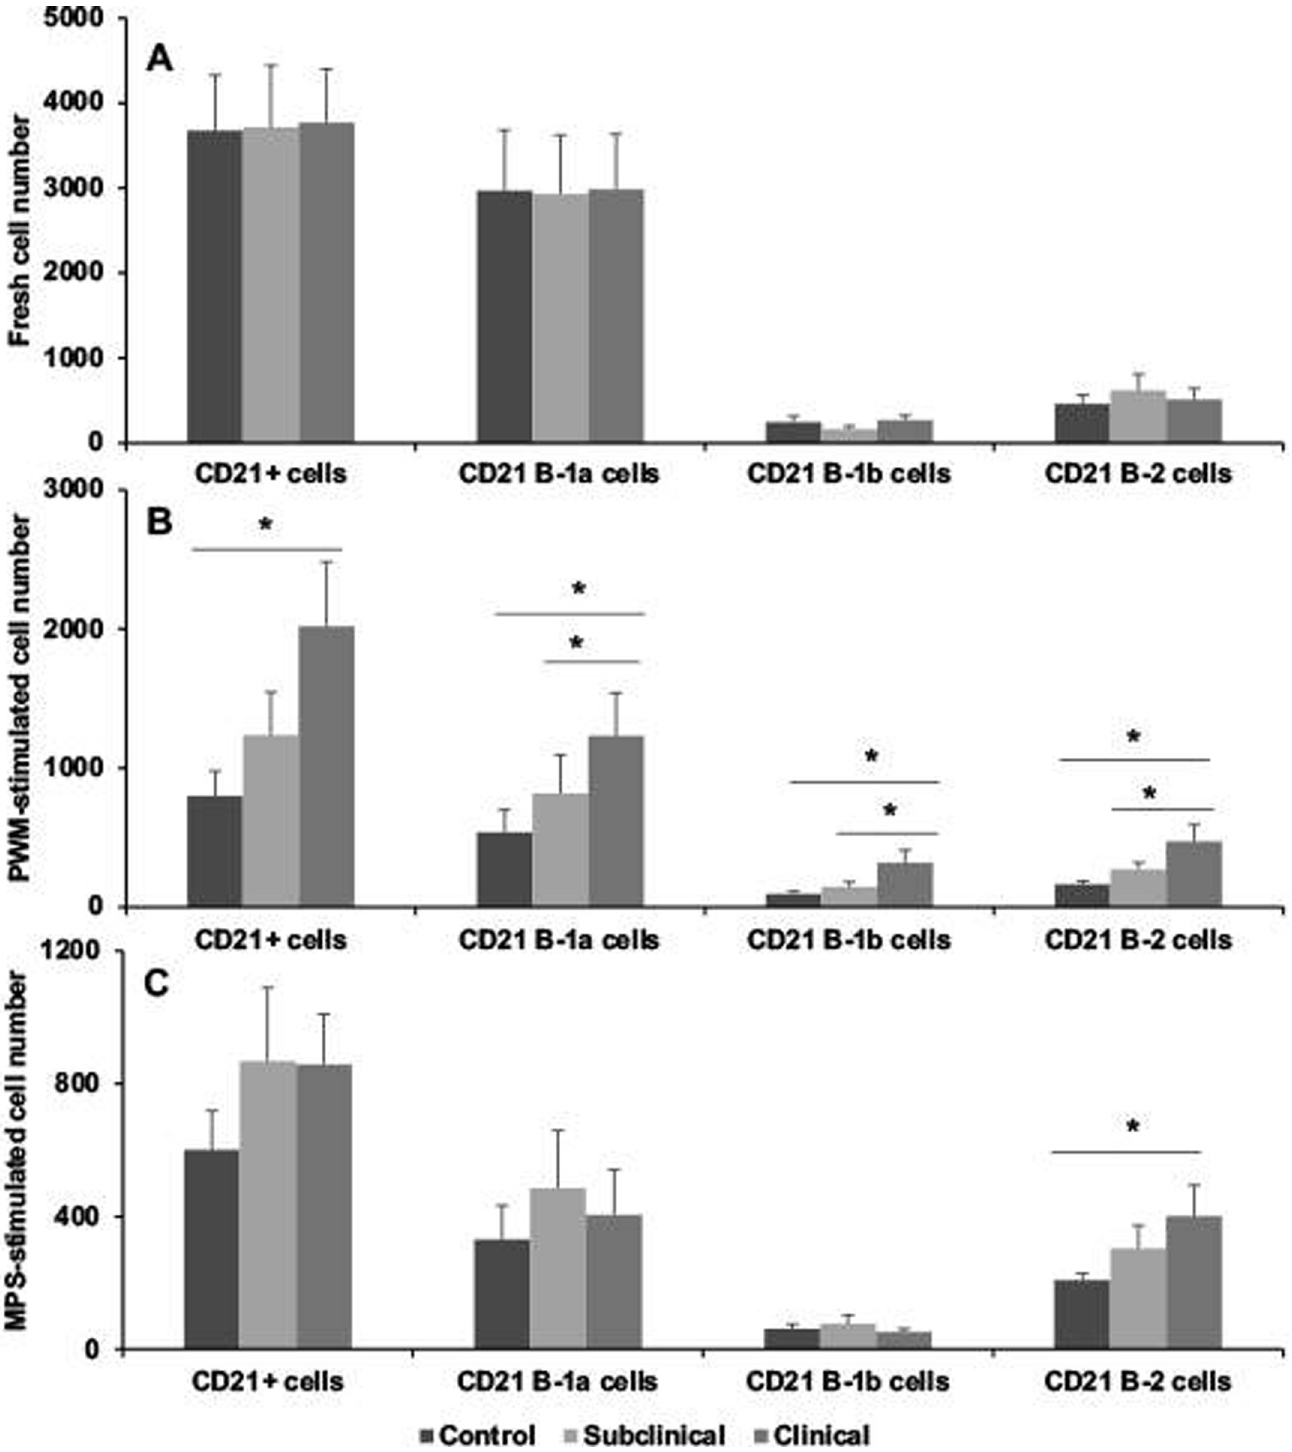
Fig 4. Flow cytometric staining of PBMCs isolated from blood of noninfected control cows and cows naturally infected with M . avium subsp. paratuberculosis using CD21 antibody as the primary B cell marker. B cells were further partitioned using CD11b and CD5 antibodies for B cell subpopulations within PBMCs that were freshly isolated (A); or incubated with pokeweed mitogen (B; 10 μ g/ml) for 3 days; or with a whole cell sonicate (MPS; 10 μ g/ml) of M . avium subsp. paratuberculosis (C; 10 μ g/ml) for 6 days in